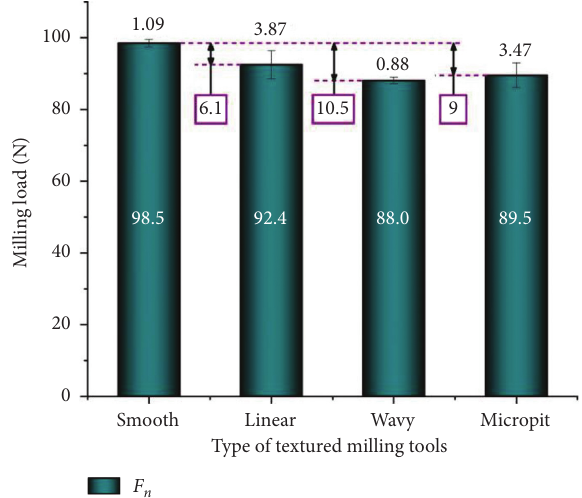
Figure 4: The resultant load of milling from different textured